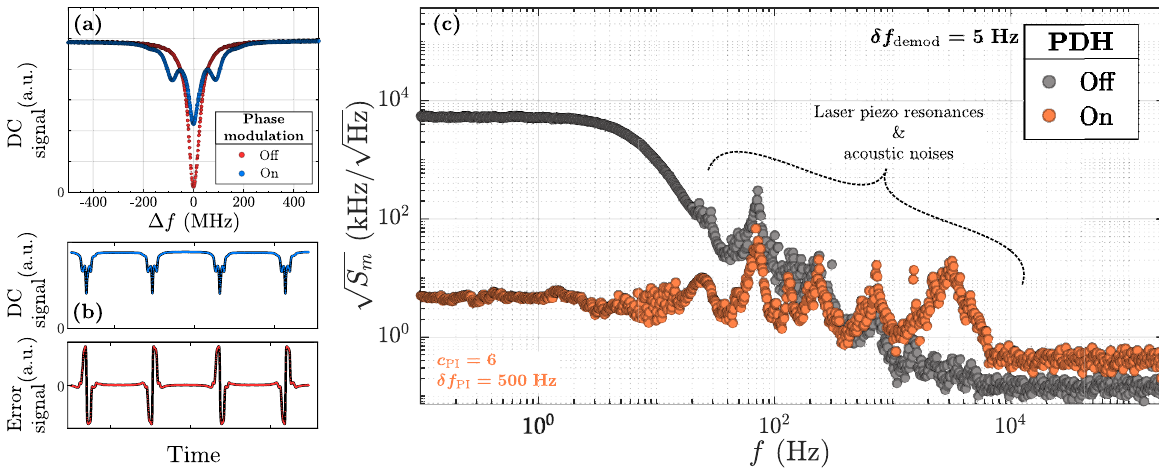
Figure 2. Noise analysis of the frequency stabilized fiber-based optomechanical cavity. ( a ) Typical spectral response (or DC signal) in reflection as a function of the frequency detuning (cid:31) f . For this example, the cavity 75MHz , and the phase modulation 42.1 MHz , the modulation frequency is f p bandwidth is around κ = = 1.08 . ( b ) Time acquisition of the DC and the corresponding error depth is close to the optimal value of β ≈ signal, with a forward/backward continuous laser wavelength scan (for qualitative purpose). ( c ) Optimized low frequency noise spectrum (or power spectral density) of the reflected signal after the noise analysis. The unit is in kHz / √ Hz which corresponds to shift of the optical resonance frequency normalized by the demodulation bandwidth δ f demod . The proportionnal factor c PI and the correction bandwidth δ f PI are indicated. The noise spectrum is displayed with and without the PDH closed loop for comparison